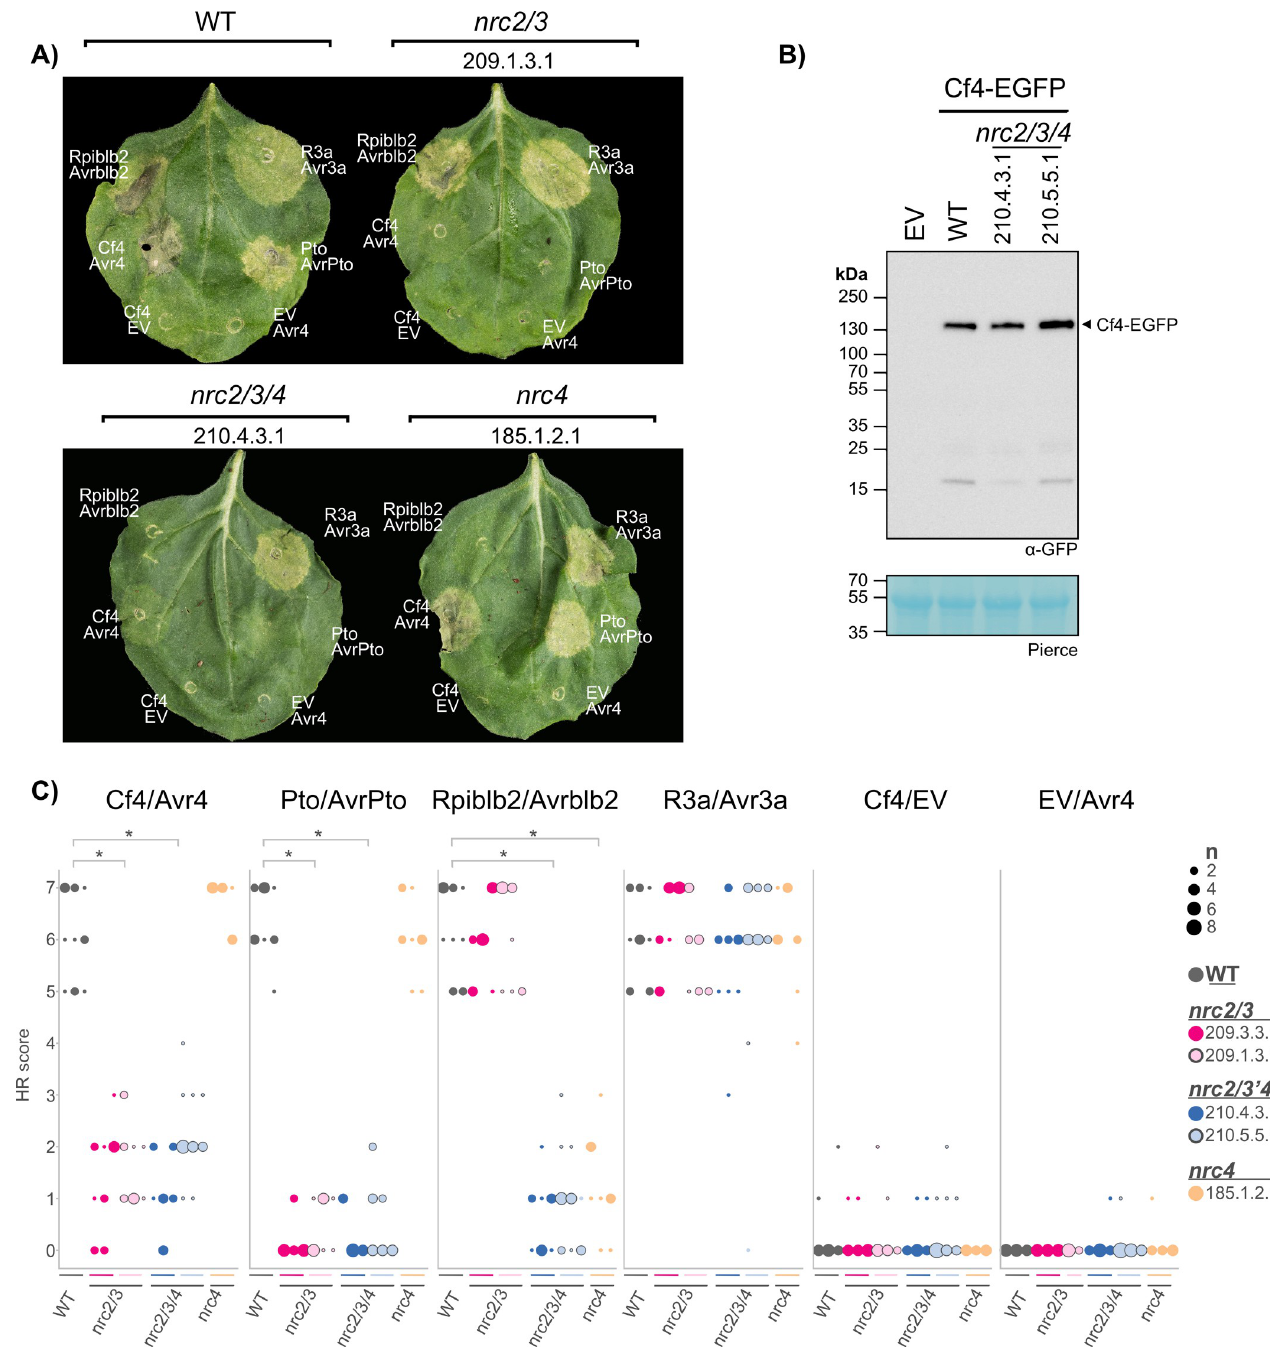
Fig 1. Cf-4/Avr4-triggered hypersensitive cell death requires NRC2/3. A ) Cf-4/Avr4-triggered hypersensitive cell death is lost in the nrc2/3 and nrc2/3/4 knock-out lines, but not in the nrc4 line. Representative N . benthamiana leaves infiltrated with appropriate constructs photographed 7–10 days after infiltration. The NRC CRISPR lines, nrc2/3 -209.1.3.1, nrc2/3/4 -210.4.3.1, and nrc4 -185.1.2.1, are labelled above the leaf and the receptor/effector pair tested, Cf- 4/Avr4, Prf (Pto/AvrPto), Rpi-blb2/AVRblb2 or R3a/Avr3a, are labelled on the leaf image. Cf-4/EV and EV/Avr4 were also included as negative controls. A representative leaf of the independent nrc2/3 -209.3.3.1, and nrc2/3/4 -210.5.5.1 CRISPR line are shown in S1B Fig ) Cf-4 protein accumulation is not affected in the nrc2/3/4 lines. For the immunoblot analysis, total protein was extracted 5 days after transient expression of Cf-4-EGFP by agroinfiltration in wild-type, nrc2/3/4 -210.4.3.1 and nrc2/3/4 -210.5.5.1 N . benthamiana leaves. Cf-4-EGFP accumulation was detected using anti-GFP antibody. C ) Quantification of hypersensitive cell death. Cell death was scored based on a 0–7 scale ( S1 Fig ) between 7–10 days post infiltration. The results are presented as a dot plot, where the size of each dot is proportional to the count of the number of samples with the same score within each biological replicate. The experiment was